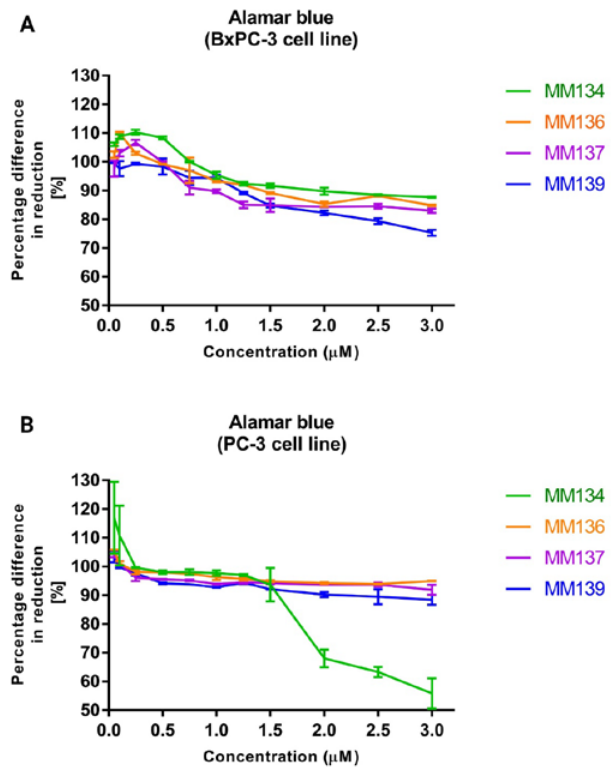
Figure 4. Alamar blue assay: the effect of MM134 , -6 , -7 , and -9 used in concentrations ranging from 0.05–3 µ M on BxPC-3 ( A ) and PC-3 ( B ) cancer cells was measured with alamar blue assay. Cells were exposed to tested compounds for 24 h at 37 ◦ C. The mean values were obtained from three independent experiments. ± SD